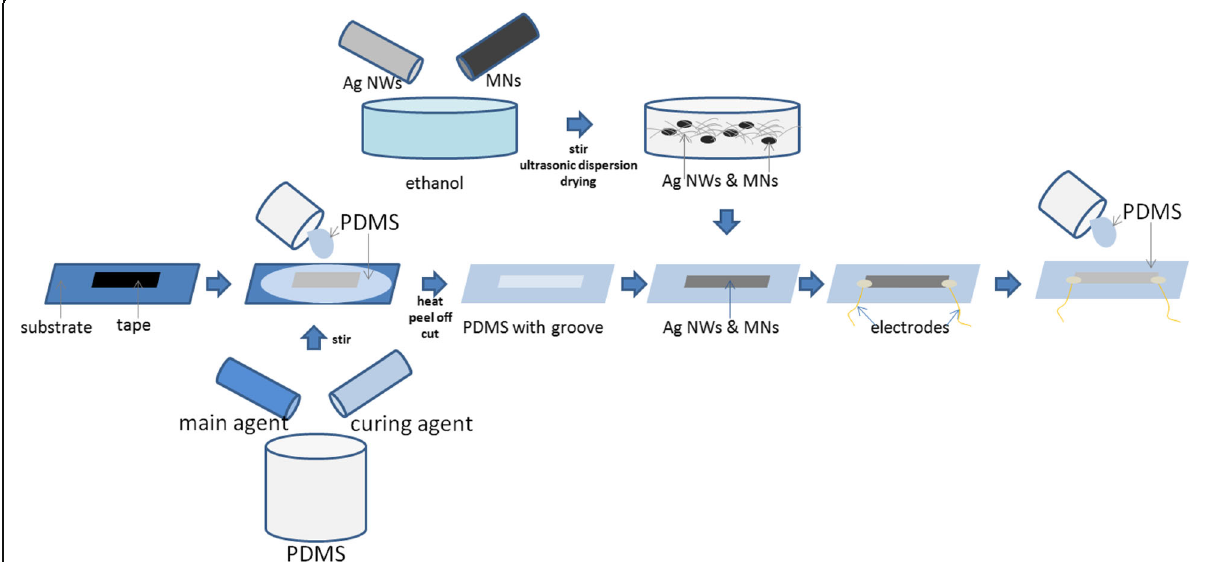
Fig. 1 Schematic of the structural design and fabrication process flowchart of the